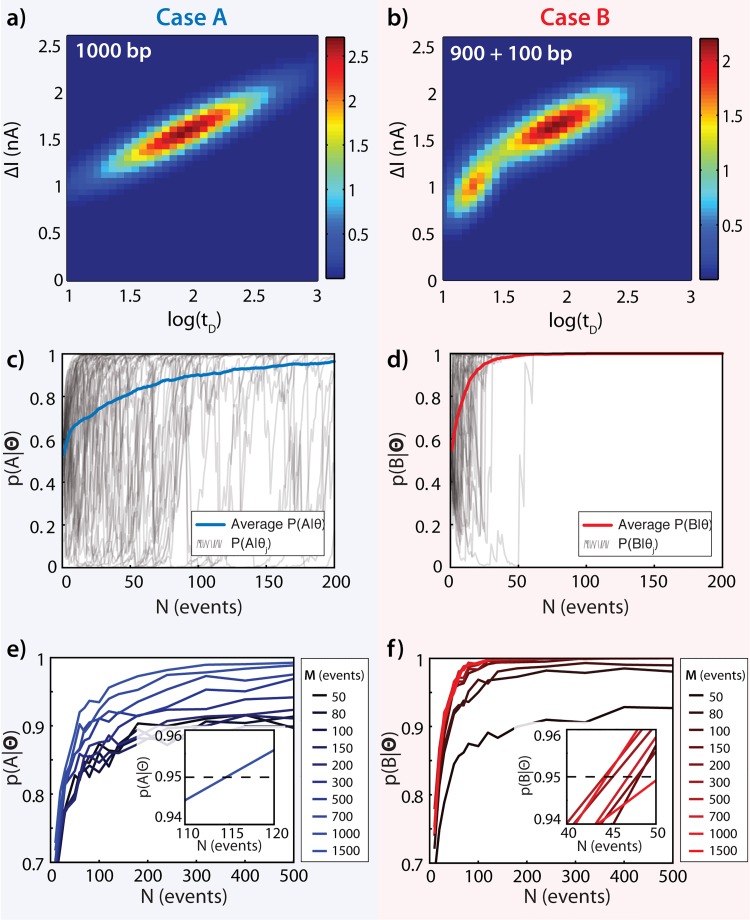
Gaussian Mixture Models for Mode II Classification of 1000 bp vs. 900+100 bp DNA Fragments.(a) 2-D GMM for 1000 bp DNA fragment translocations. (b) 2-D GMM for 900+100 bp DNA fragment translocations. (c) Bayesian posterior estimates p(A|Θ) of correctly identifying a data set Θ as Case A, calculated for each increment of N points in Θ, repeated 1000 times (first 50 shown in gray) and averaged (blue), each using M = 1500 points in the model data set. (d) Bayesian posterior estimates p(B|Θ) of correctly identifying a data set Θ as Case B, calculated for each increment of N points in Θ, repeated 1000 times (first 50 shown in gray) and averaged (red), all using M = 1500 points in the model data set. (e) Bayesian posterior estimates p(A|Θ) for test data sets of N points given a model based on data set size M. Each point represents the average of 1000 separate bootstrap simulations. (f) Bayesian posterior estimates p(A|Θ) for test data sets of N points given a model based on data set size M. Each point represents the average of 1000 separate bootstrap simulations. Insets: range of N for which p(A|Θ) reaches 0.95. See Methods and S1 File for complete numerical simulation details.